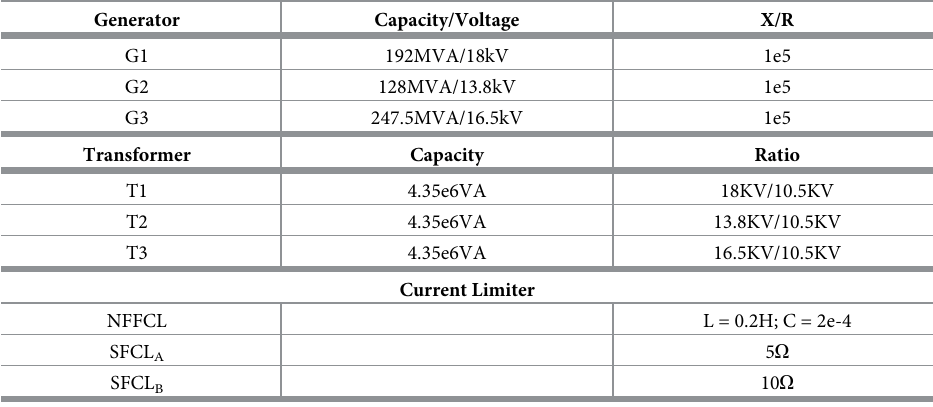
Table 2. Main simulation parameters of system